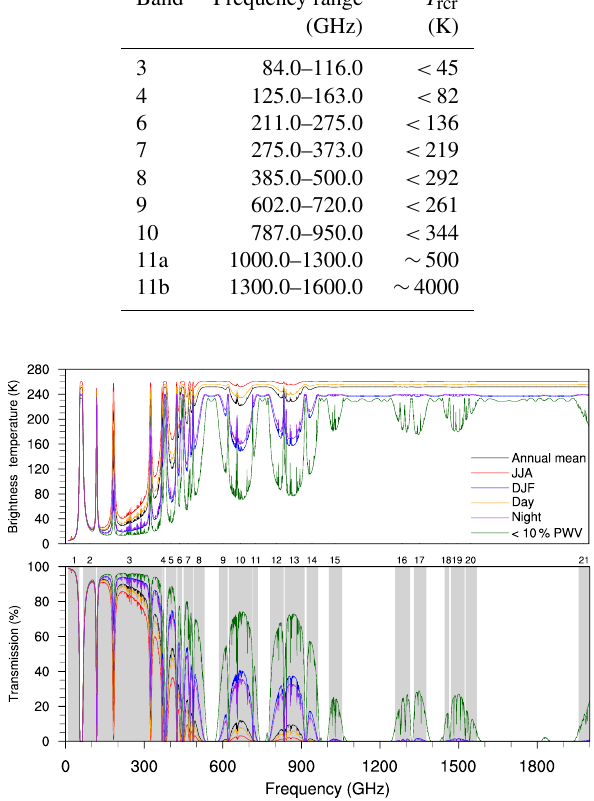
Figure 6. Downwelling brightness temperatures (top) and transmis- sion (bottom) simulated by ARTS for the six scenarios, as viewed from the ground at Summit, Greenland (zenith angle=0 ◦ ). Full and partial window bands (consecutive frequencies with high trans- mission relative to those surrounding them) are shaded in grey on the lower panel and numbered above. The sampling resolution is